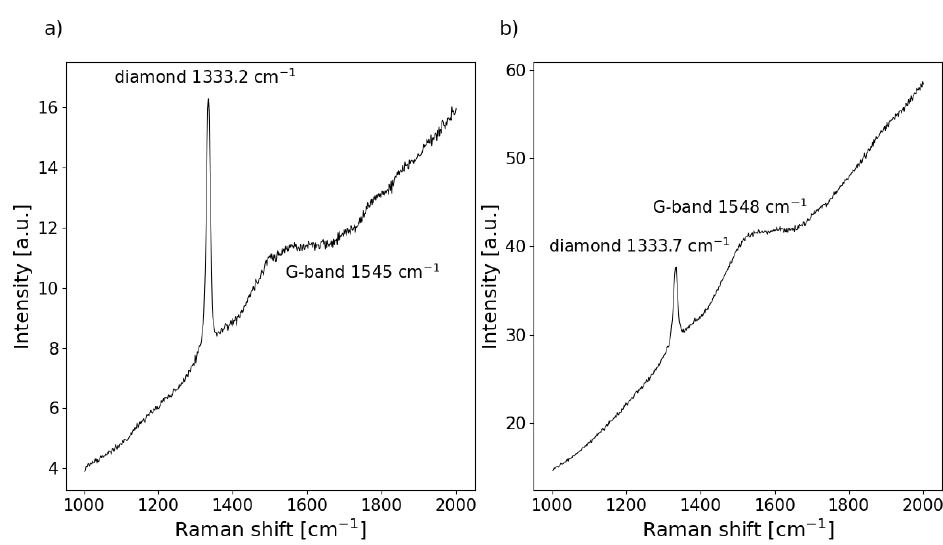
Figure 2. The Raman spectra of the studied films ( a ) DFI and ( b )